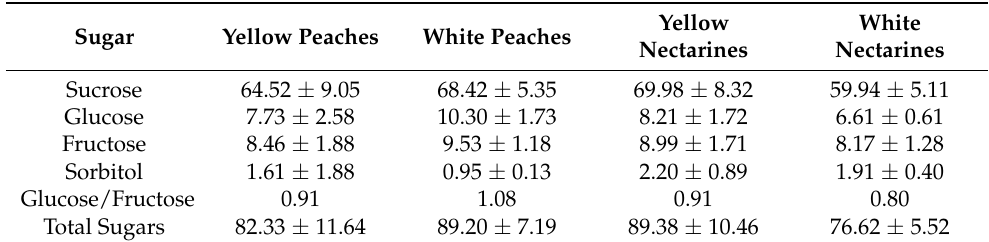
Yellow White Nectarines Nectarines 0.80